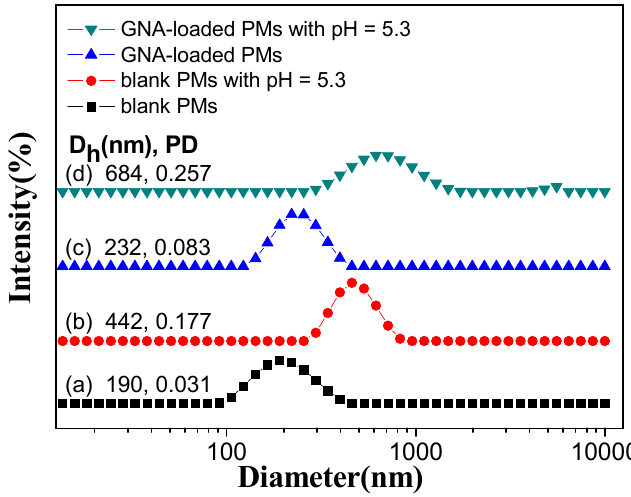
Figure 3. Influence of pH on DLS plots of PCL- b -PAA aggregates (c = 1.4 mg mL − 1 ) (a and b) and treated with HCl (0.1 mol L − 1 ) for 2 h (b and d).